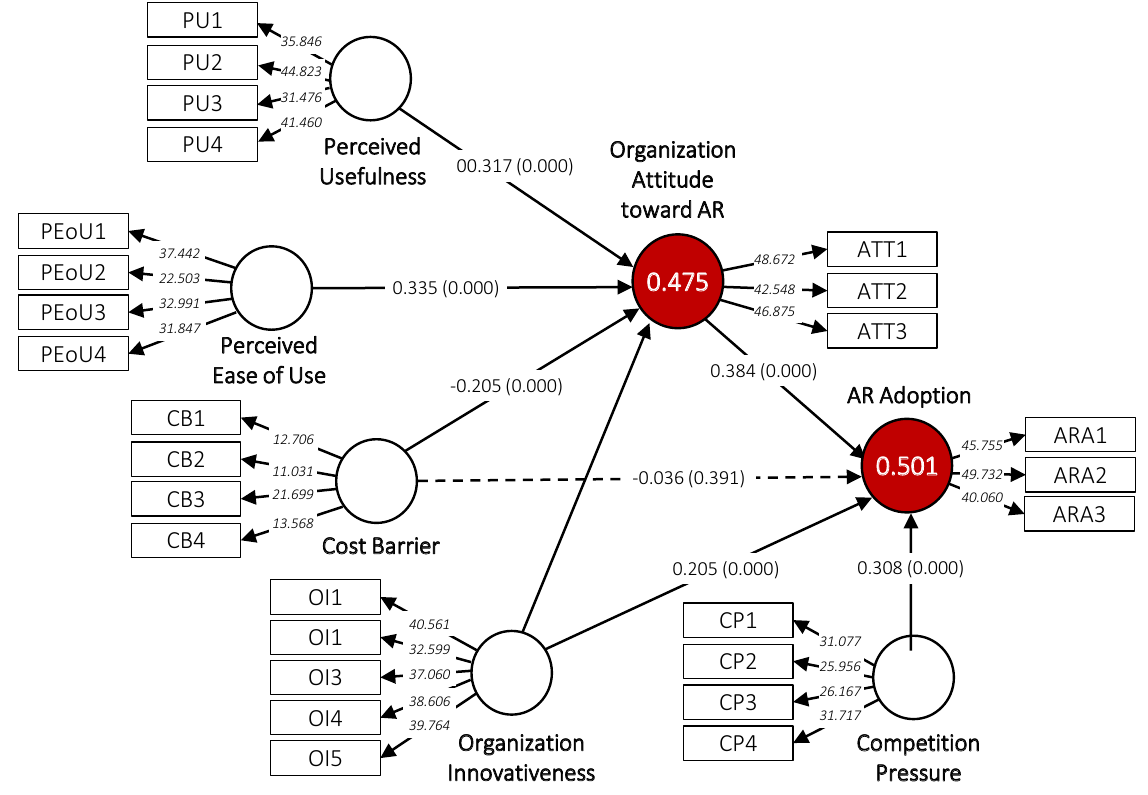
Figure 2. Structural